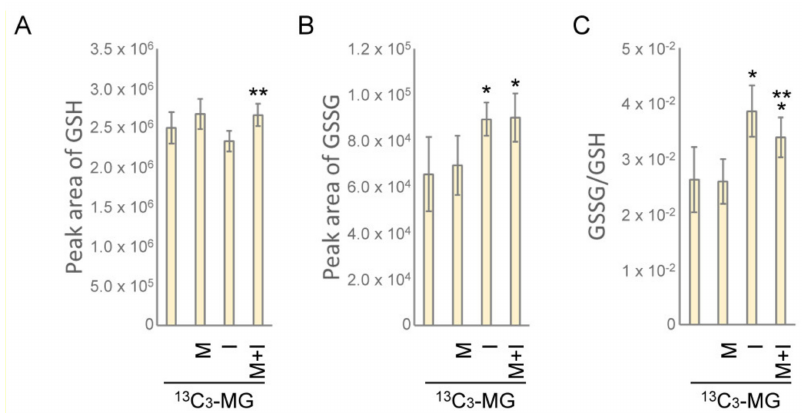
Figure 7. The change of intracellular reduced and oxidized glutathione in insulin- and metformin-treated HEK293T cells. The intracellular levels of ( A ) reduced glutathione (GSH) and ( B ) oxidized glutathione (GSSG) and ( C ) the ratio of GSSG/GSH were determined by LC-ESI-MS. Cells were treated with M: 10 mM metformin; I: 10 ng/mL insulin; M+I: 10 mM metformin + 10 ng/mL insulin in the presence of 80 µ M 13 C 13 C 3 -MG ( 3 -MG) for 4 h. Results significantly different from control and I at p < 0.05 are, respectively, indicated by * and ** ( n =